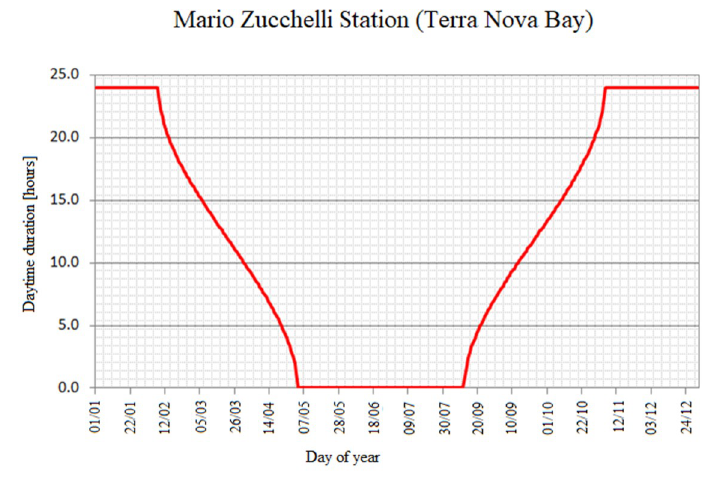
Figure 3. Daytime duration during the year at the MZS.